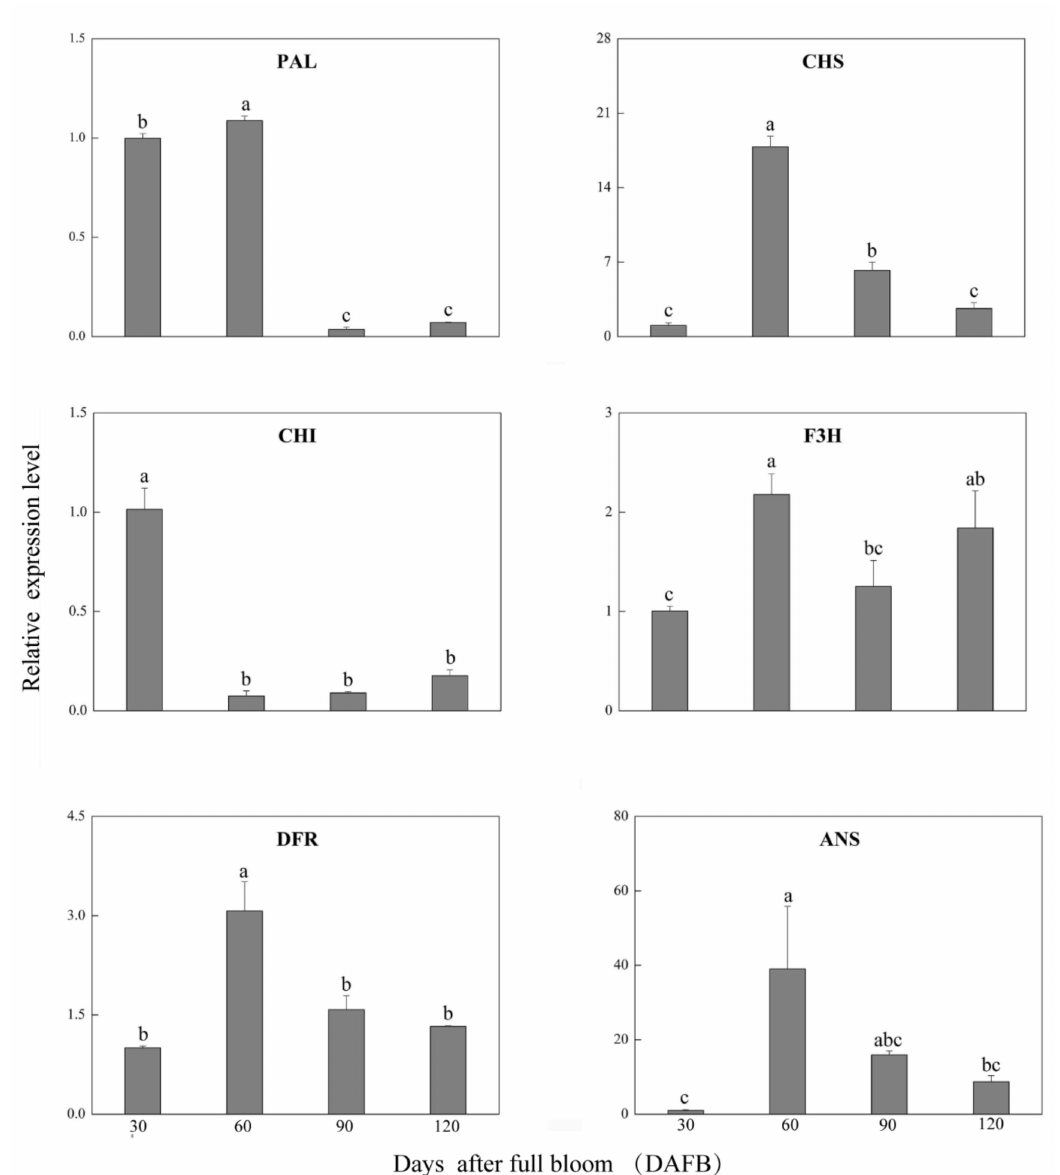
Figure 4. Expression patterns of the anthocyanin biosynthetic genes at different fruit development stages. Different lowercase letters indicate significant differences by ANOVA and Duncan’s test at p <